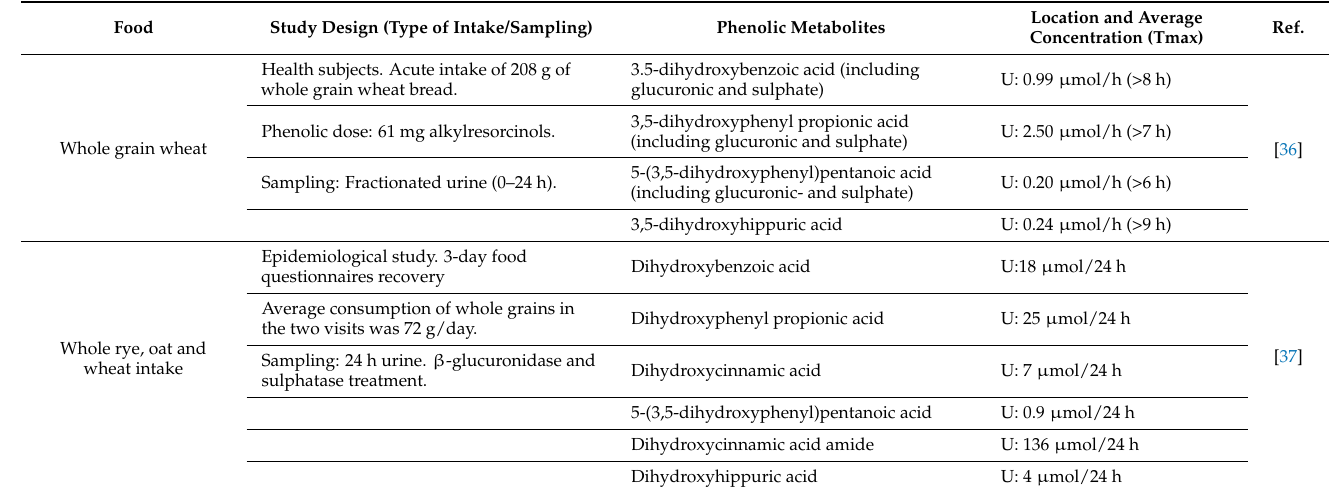
Table 2. Phenol metabolites (phase I, phase II) detected in human biofluids proposed as intake biomarkers of whole grains commonly consumed in the Mediterranean